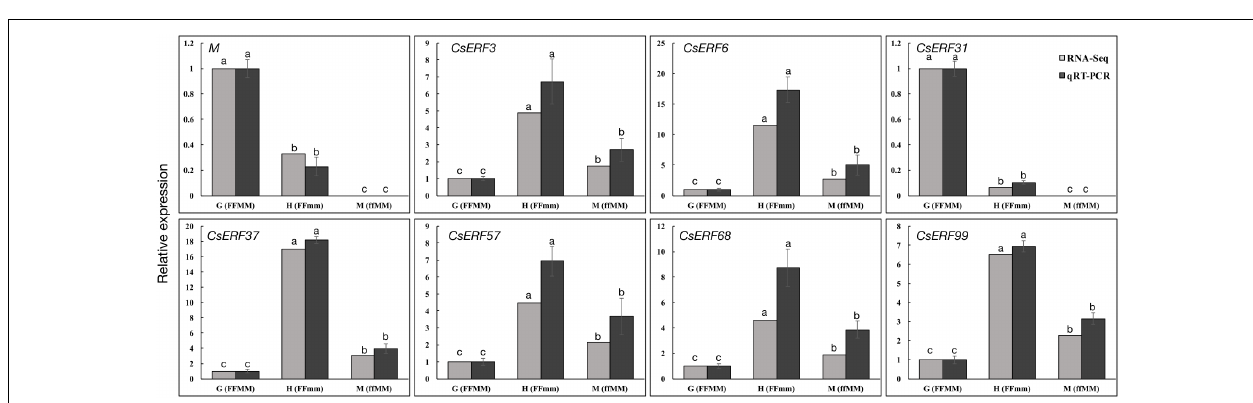
FIGURE 3 | qRT-PCR validation of ERF family genes identified by RNA-Seq. Seven ERF family genes and M were selected from DEGs of the two sets of transcriptome comparisons (G12 vs. M12, and G12 vs. H34) for qRT-PCR confirmation. The cucumber Actin was used as an internal control (Li et al., 2012), and these experiments were repeated with three biological samples. Error bars represent the SD from three biological replicates. Different letters (a–c) indicate significant differences ( P < 0.05) of 7 ERF family genes and M in G12, H34, and